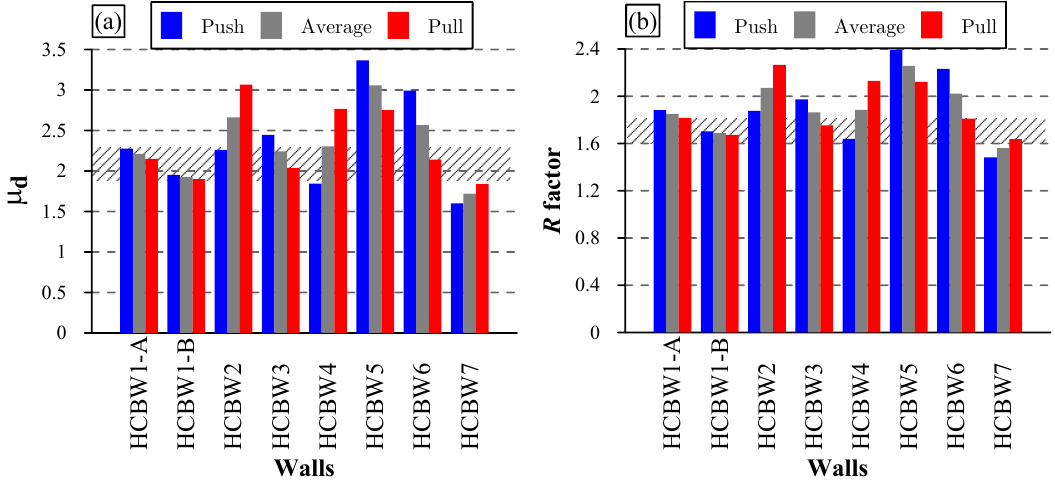
Figure 15. ( a ) Displacement ductility; and ( b ) seismic force-reduction (R)